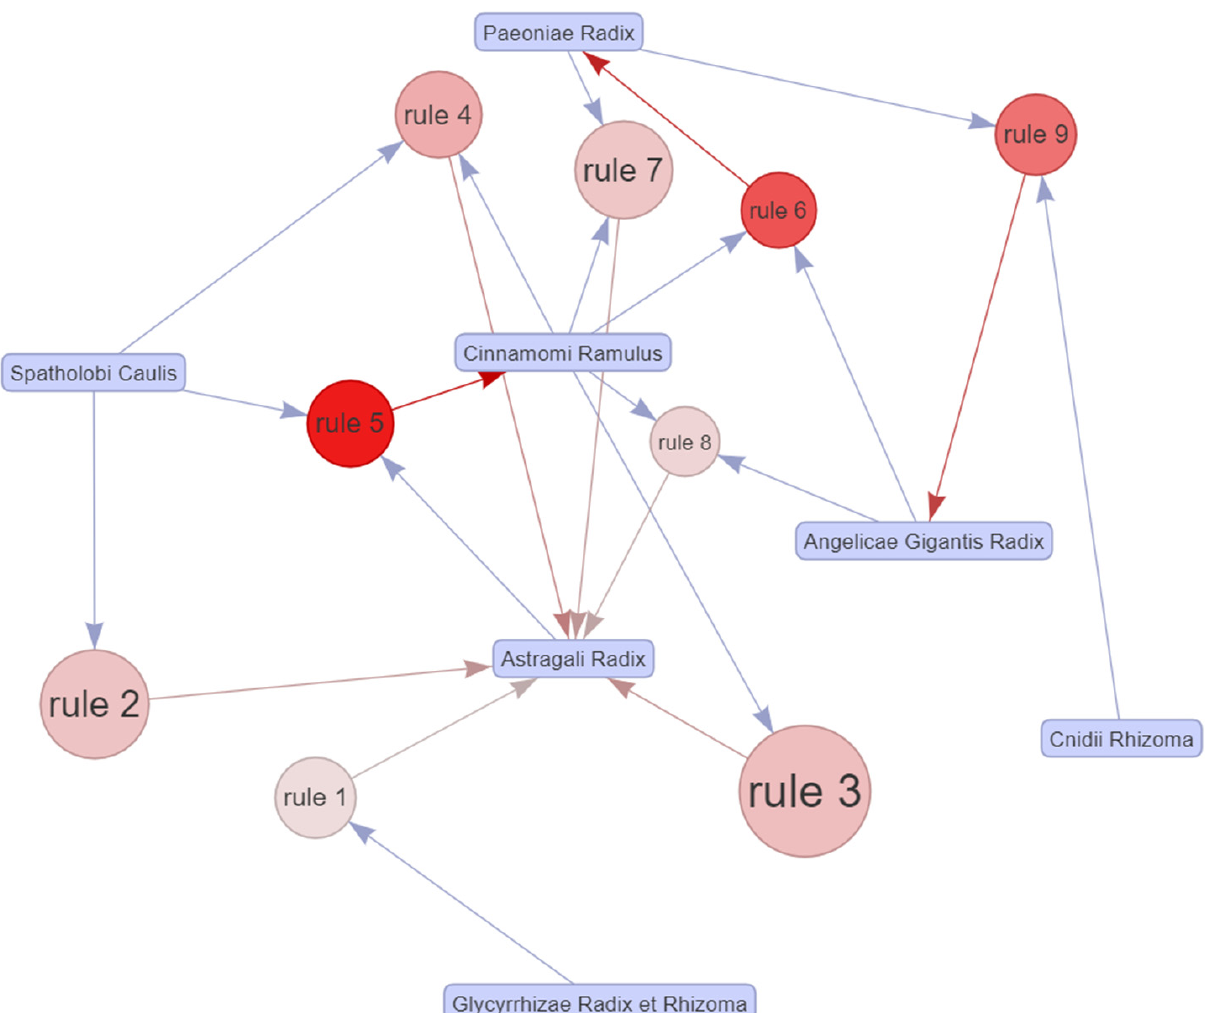
Figure 16. Network graph of the association rules in the meta-analysis of East Asian herbal medicine prescribed for peripheral neuropathy.